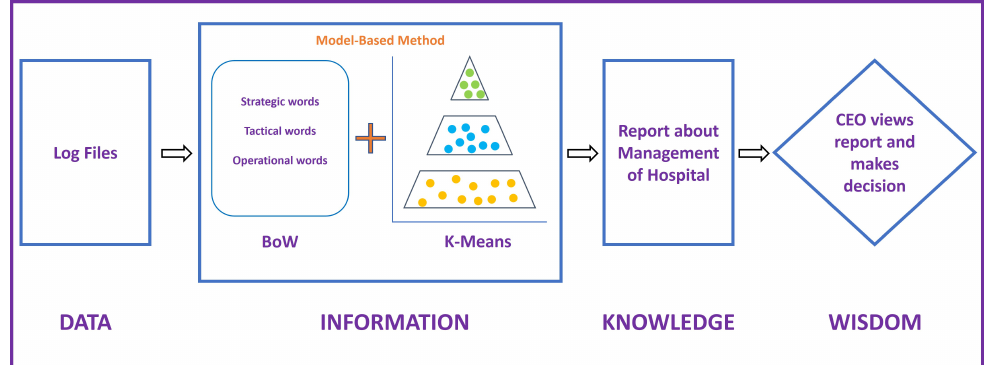
Figure 3. The general scheme of the